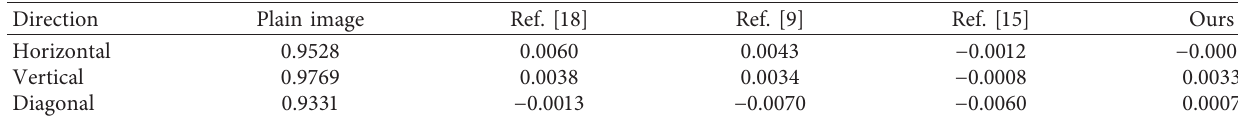
Figure 13: The adjacent-pixel distribution maps of the input images and the cipher images. (a) Baboon. (b) House. (c) Barche. (d) Peppers. Table 9: Correlation coefficient of house with different algorithms.